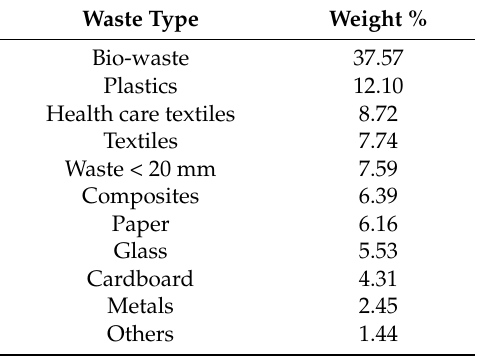
Table 2. Characterization of the material received in the energy recovery plant, in 2015.